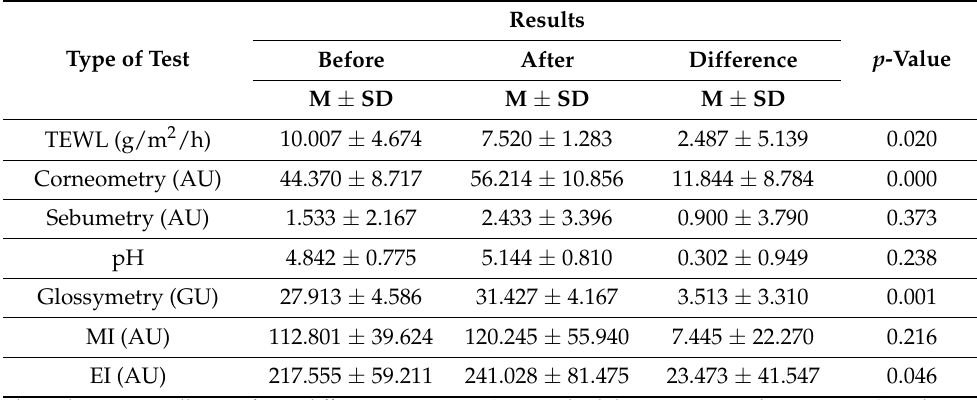
Table 8. Comparison of the skin biophysical parameters before and after 6 weeks of using the tested clothing.